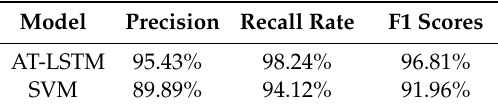
Table 13. Model performance evaluation.